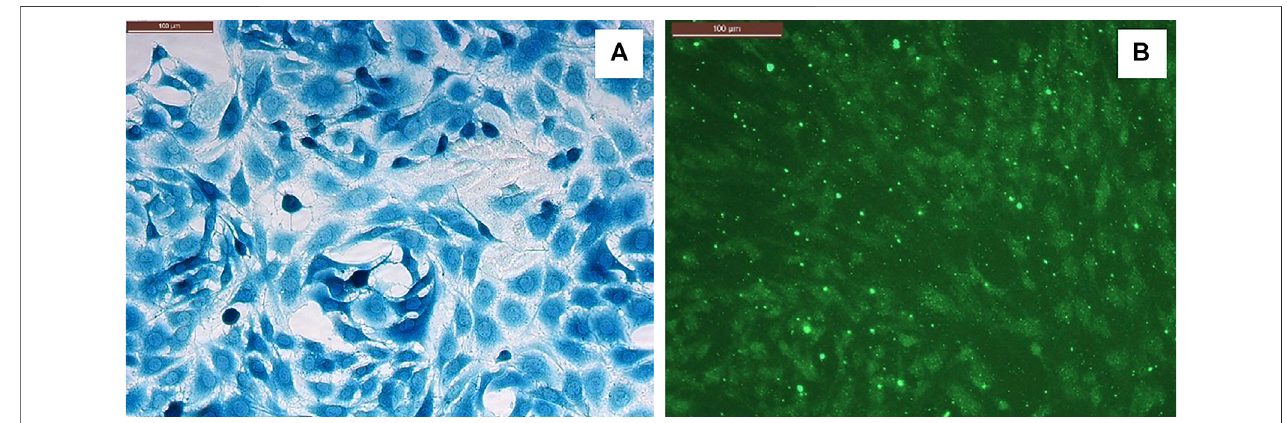
FIGURE 2 | (A) Gliomacells (CRL2303)stained against β -galactosidasegene. (B) BMVECsstained against VWF.Scale bar (upperleftinboth panels) (cid:2) 100